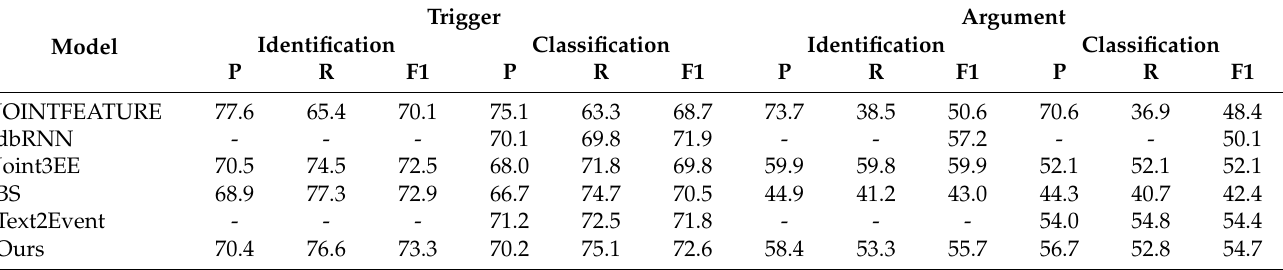
Table 3. Results from the ACE2005 dataset.